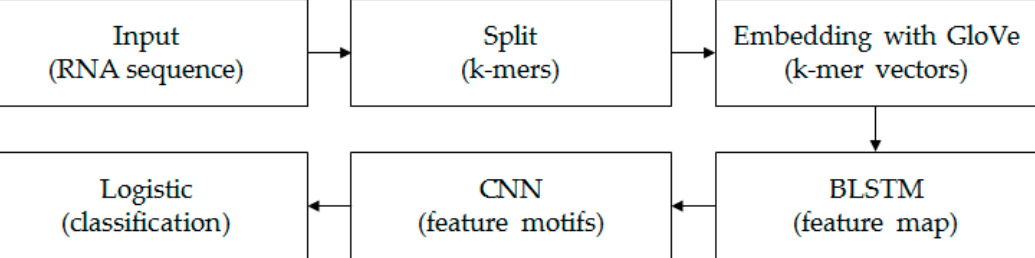
Figure 1. The structure diagram of the model. We first split each input RNA sequence into k -mers using a moving window approach [21]. Then, based on all k -mer sequences, all the k -mer embedding vectors were learned by the unsupervised GloVe method. The embedding layer embedded all k -mers into the vector space and turned the k -mer sequence into a real matrix. The BLSTM layer consisted of two LSTMs layers that were parallel but opposite in direction, to capture long-term dependency information between sequences. The following CNN with three convolution layers scanned the above results using multiple convolutional filters to obtain different features. The final fully connected layer and logistic acted as classifiers to get the probability and final classification result of the input sequence belonging to a positive or negative class.